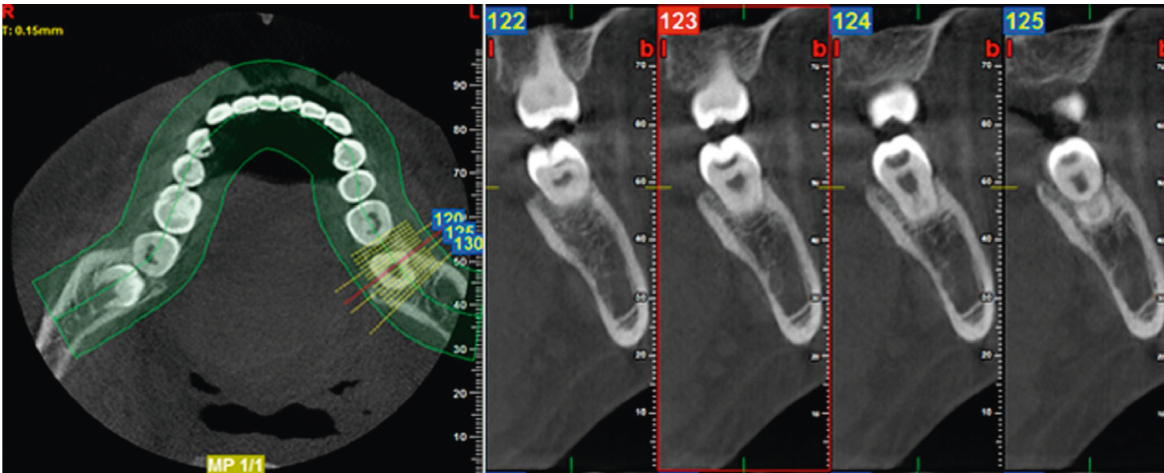
Figure 6: Sagittal slices of the PEIR-affected tooth (permanent mandibular left second molar) reconstructed from the second CBCT when the patient was 14 years, 9 months old. The PEIR location was reconfirmed to be just under the dentino-enamel junction and not connected to the pulp chamber or oral environment. The distance between the midfloor of the lesion and the pulpal area is 2.00mm. The PEIR dimension is 2.30 mm occluso-gingival depth, 4.00mm bucco-lingual width, and 3.40mm mesio-distal